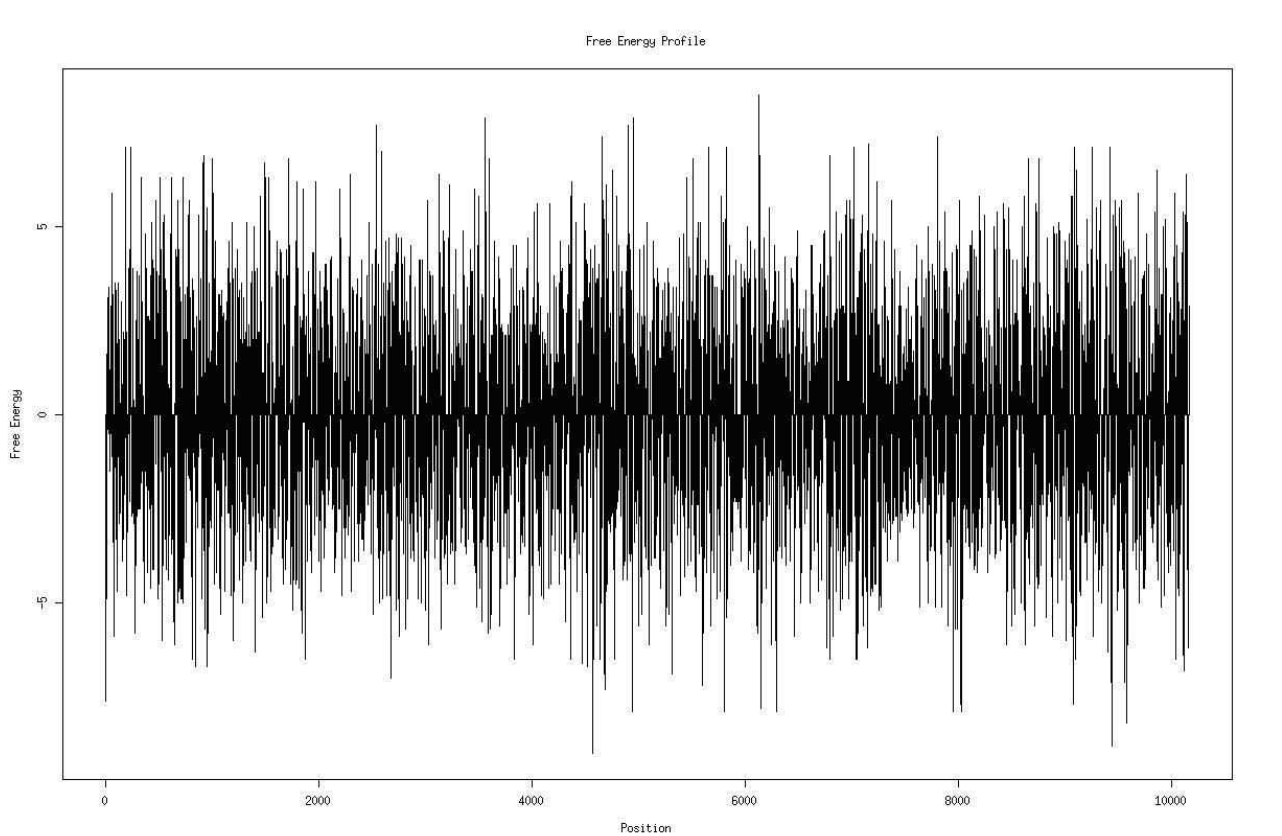
Figure S3. The Gibbs free energy ( ∆ G) landscape of a gene sequence. The Strand Analysis (SA) program calculates the ∆ G value of each small interfering RNA (siRNA) along a specific DNA sequence and displays them in a comprehensive fashion, see graphic below using the human MeCP2 sequence (AF158180), with ∆ G in the Y axis and the gene position in the X axis. This analysis indicates possible ∆ G hotspots along the sequence and may also provide information regarding the ∆ G profile of viral genomes, thus shedding light on viral adaptation to host RNAi